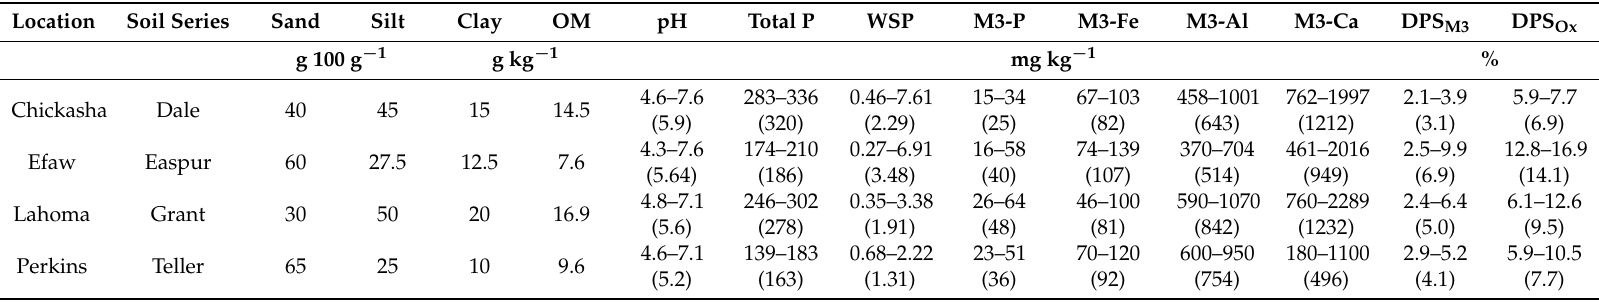
Table 1. General soil characteristics among the four locations used in the study. Sand, silt, clay, and organic matter (OM) values are means. Values shown for pH, total P, water-soluble P (WSP) and Mehlich-3 (M3) extractable elements are the range, with means indicated in parentheses. DPS = degree of P saturation calculated